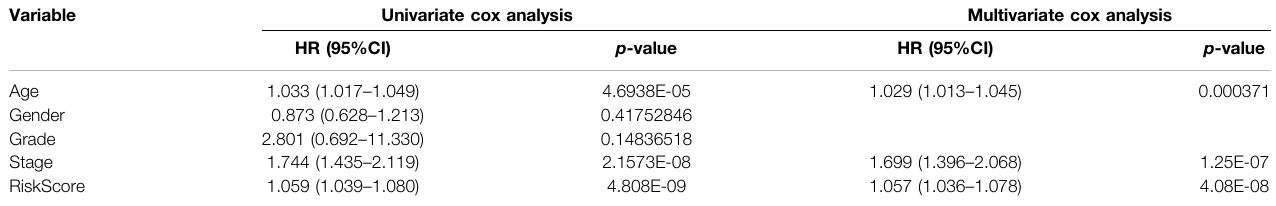
TABLE 3 | Cox regression analysis of clinical characteristics and risk score (RS) affecting patients ’ prognosis in combined set. Variable